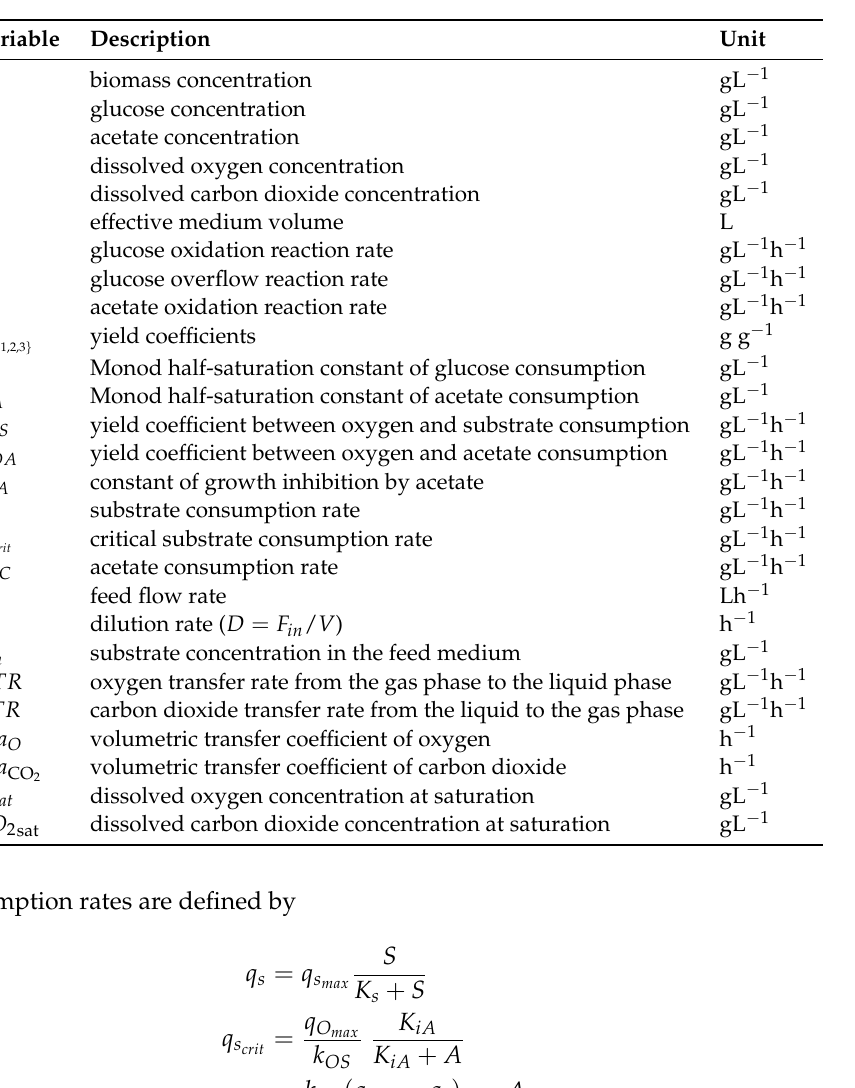
Table 1. Variables and